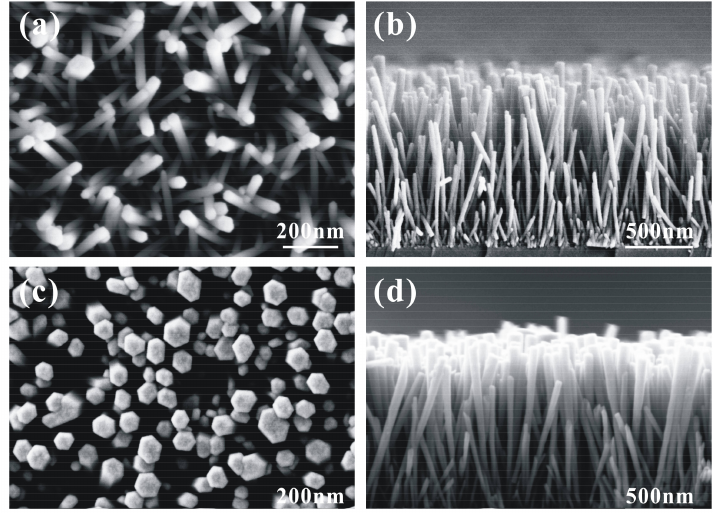
Figure 2. ( a , b ) The top-view and cross-section SEM images of the sample L-0 which was synthesized with 0.01 M precursor concentration in T1 for 2 h without T2 treatment. ( c , d ) The top view and cross-section SEM images of the sample L-2 which was synthesized with 0.01 M precursor concentration in T1 for 2 h, and with 0.05 M precursor concentration in T2 for 2